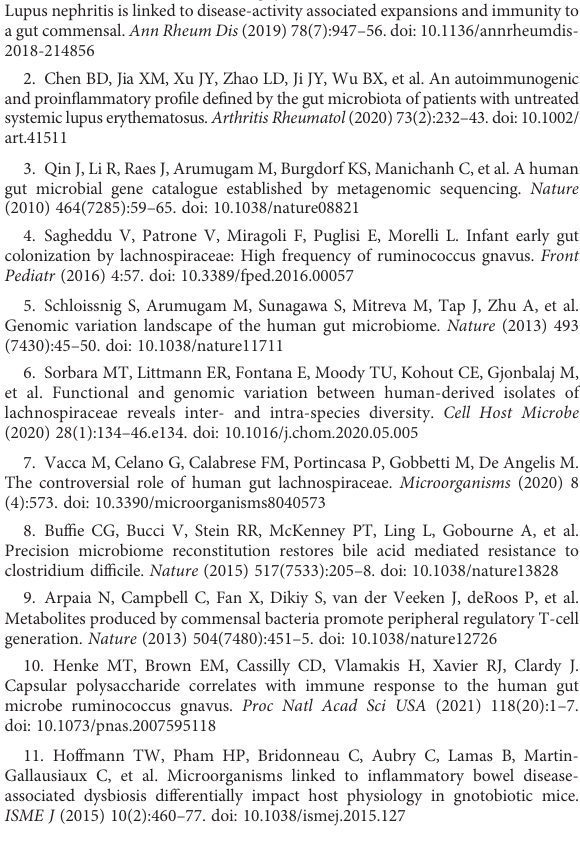
SUPPLEMENTARY FIGURE 1 In colonization studies into Germ-Free mice, sham gavage or gavage with viable RG1, RG2 and S107-48 was used. In colonization studies with antibiotic pre-treated mice, sham gavage or gavage with Control sham tested viable RG2, S107-48 and S47-18 was